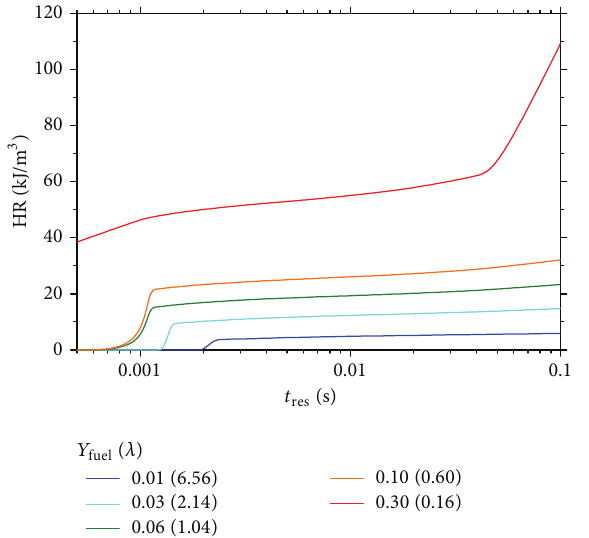
Figure 6: Predictions of fuel consumption rate per unit volume as a function of inlet temperature for 5 characteristic values of fuel in = 30 ms). concentration ( 𝑡 res